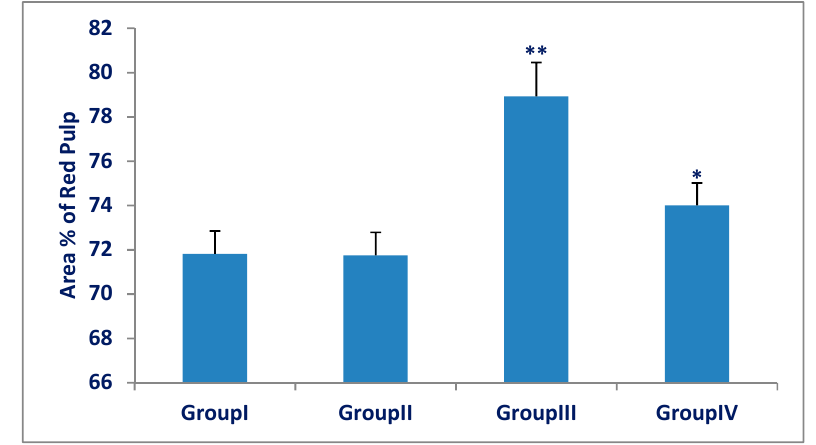
Figure 4. Area percentage of red pulp of spleens in group (III) (Olanzapine group) was significantly increased as compared to group (I) (control group). Group (IV) (Olanzapine and vitamin C) was significantly decreased as compared to group (III). The di ff erences in area percentage of red pulp between the control group (I) and Vitamin C group (II) were not significant ( p > 0.05). Results are expressed as mean ± SD and the level of significance was set for p -values less than 0.05. **: significant increase, group (III) versus group (I) ( p < 0.001). *: significant decrease, group (IV) versus group (III) ( p <